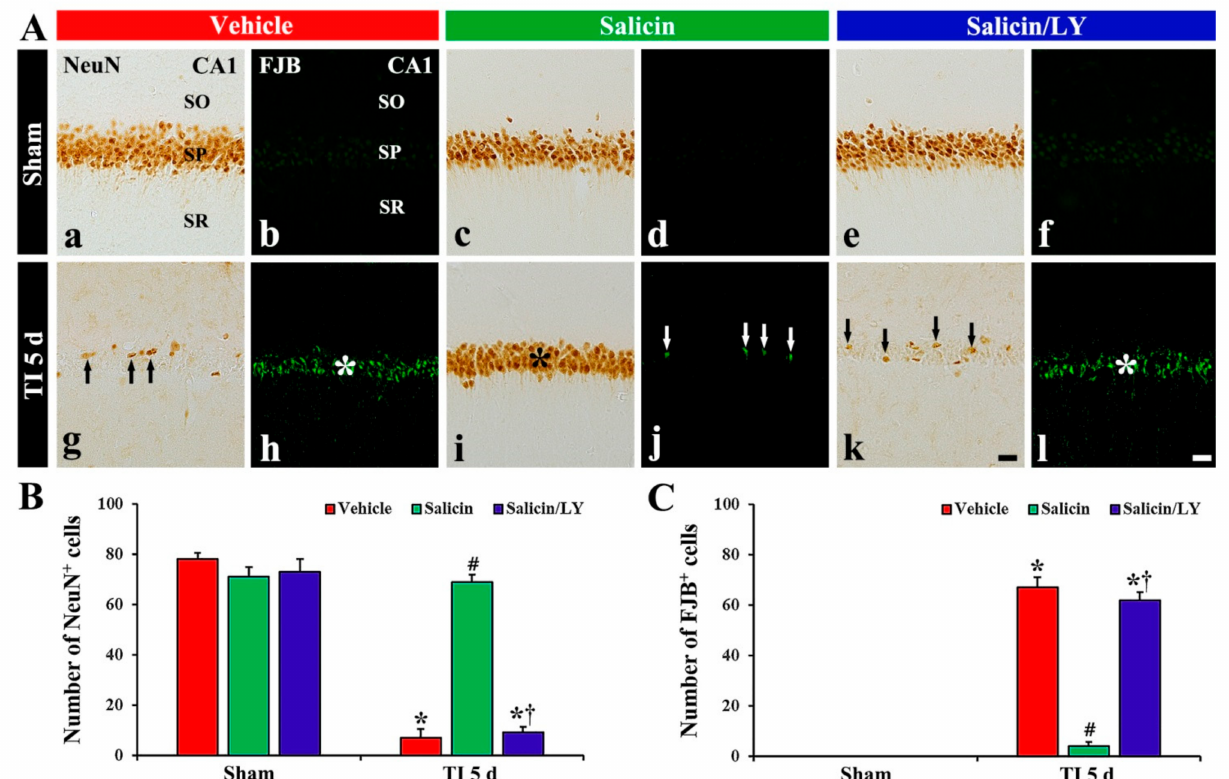
Figure 2. ( A ) NeuN immunohistochemistry ( a , c , e , g , i , k ) and FJB histofluorescence ( b , d , f , h , j , l ) in CA1 of the vehicle-sham ( a , b ), vehicle-TI ( g , h ), salicin-sham ( c , d ), salicin-TI ( i , j ), salicin/LY-sham ( e , f ), and salicin/LY-TI ( k , l ) groups at 5 days post-TI. A few NeuN + pyramidal cells (black arrows) and many FJB + pyramidal cells (white asterisk) are detected in the vehicle-TI group. In the salicin-TI group, however, abundant NeuN + cells (black asterisk) and a few F–J B + cells (white arrows) are observed in the SP. On the contrary, in the salicin/LY-TI group, the distribution pattern and number of NeuN + and FJB + cells (black arrows and white asterisk) in the SP are similar to those in the vehicle-TI group. Scale bar = 50 µ m. ( B , C ) The mean numbers of NeuN + pyramidal neurons ( B ) and FJB + pyramidal neurons ( C ) in CA1. The bars indicate the means ± SEM ( n = 5/group, * p < 0.05 vs. each sham group, # p < 0.05 vs. vehicle-TI group, † p < 0.05 vs. salicin-TI group; the vehicle-sham group was regarded as control